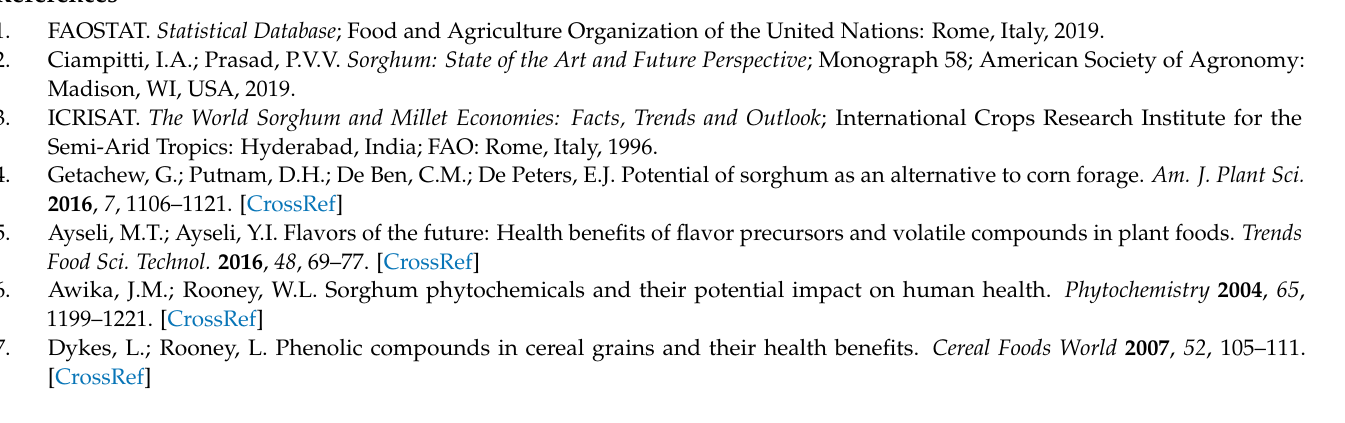
using MS-DIAL; Figure S2: GC-MS/MS derived chromatograms of sorghum grains differing in grain color; Table S1: Details of sorghum accessions used (grain color descriptor, origin and type); Table S2. List of metabolites identified in the grains of 61 diverse sorghum accessions; Table S3. Abundance ratio of 163 metabolites showing more than 2 fold change between colored and white grain